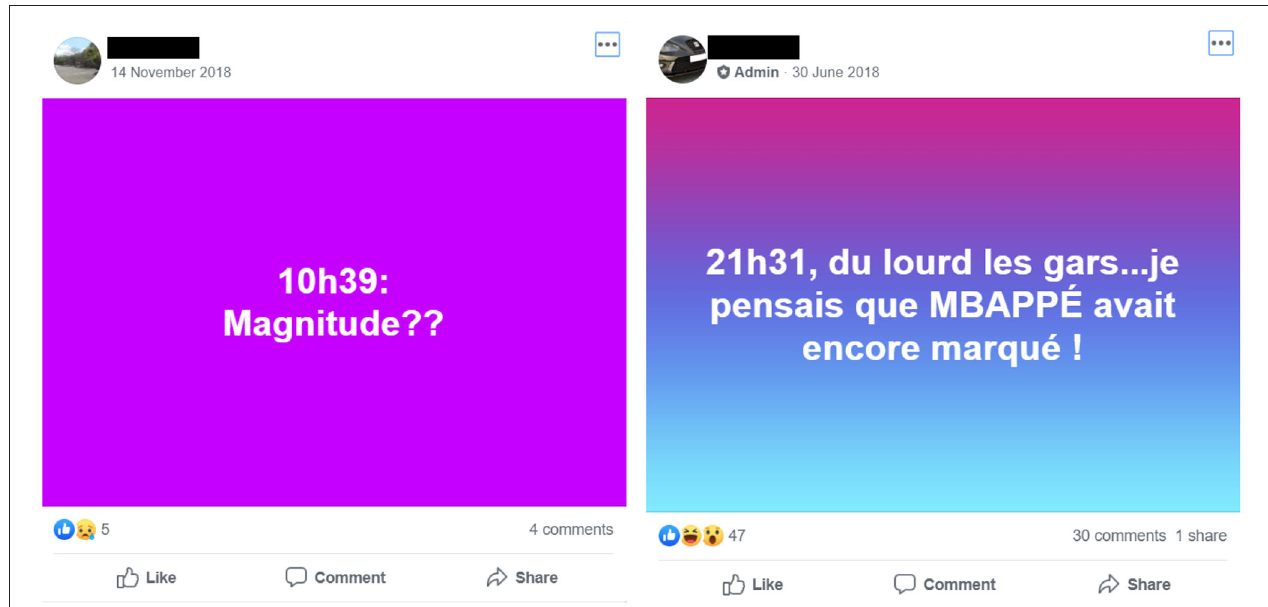
FIGURE 4 | On STTM Facebook group, a citizen wonders about the magnitude of an earthquake he just felt (Left). Citizens also use humor to describe earthquakes they felt. “21H31, heavy stuff guys, I thought Mbappé had scored again!” (Right).